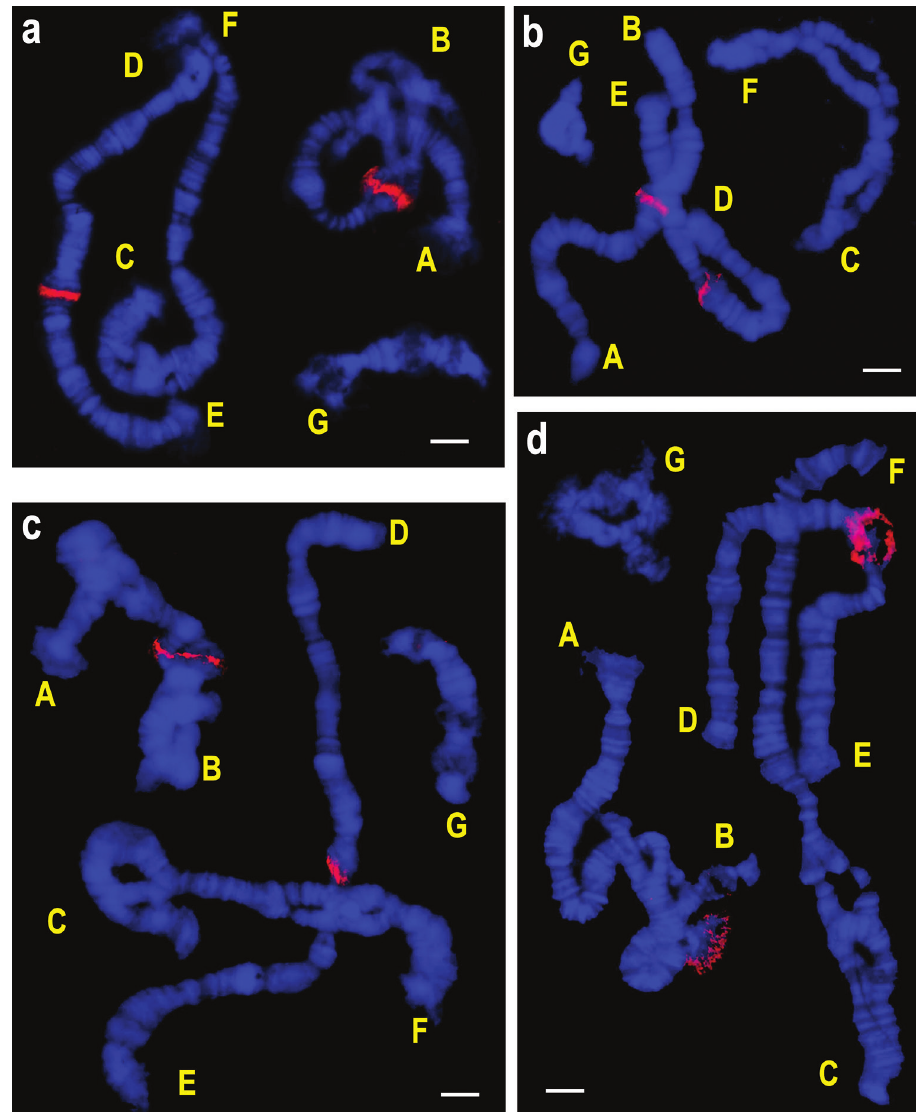
Figure 1. FISH of homologous ( a ) and heterologous ( b–d ) rDNA probes on the polytene chromosomes of C. tentans. a ITS-1 + 5.8S_ten (Cy3) b ITS-1 + 5.8S_pal (Cy3) c ITS-1 + 5.8S_dil (Cy3) d ITS-1 + 5.8S_set (Cy3). Letters designate chromosomal arms. Bar = 10